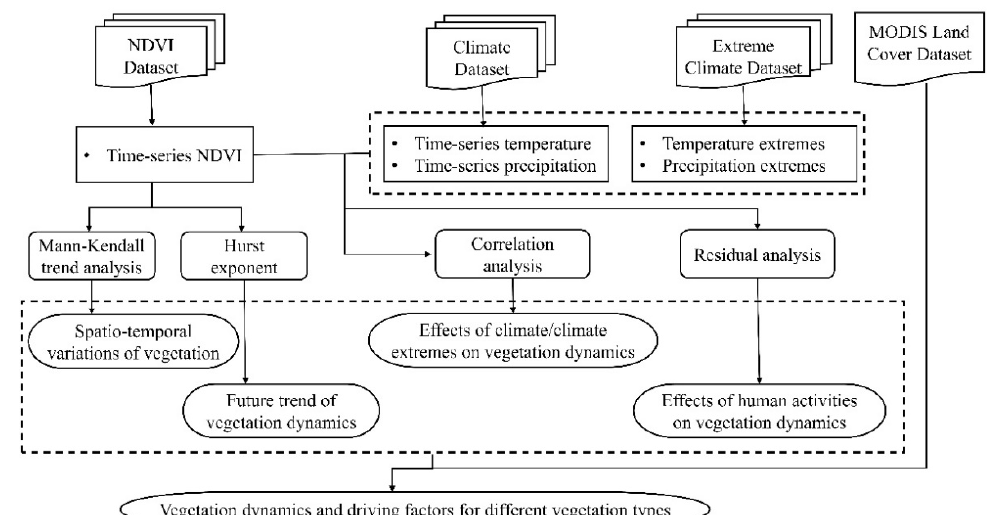
Figure 2. Flow chart of this study.